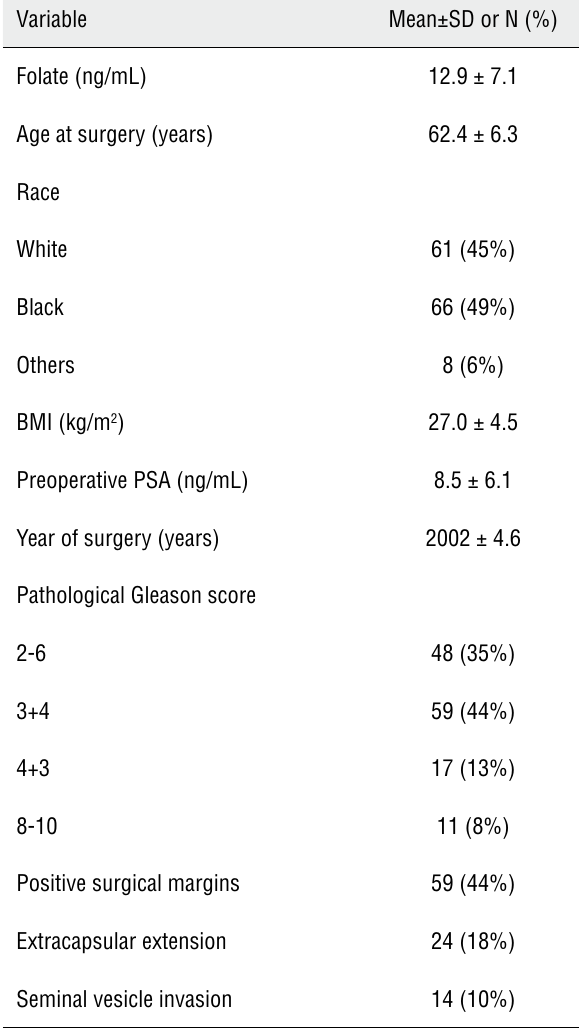
Table 1 - Patient demographics and tumor